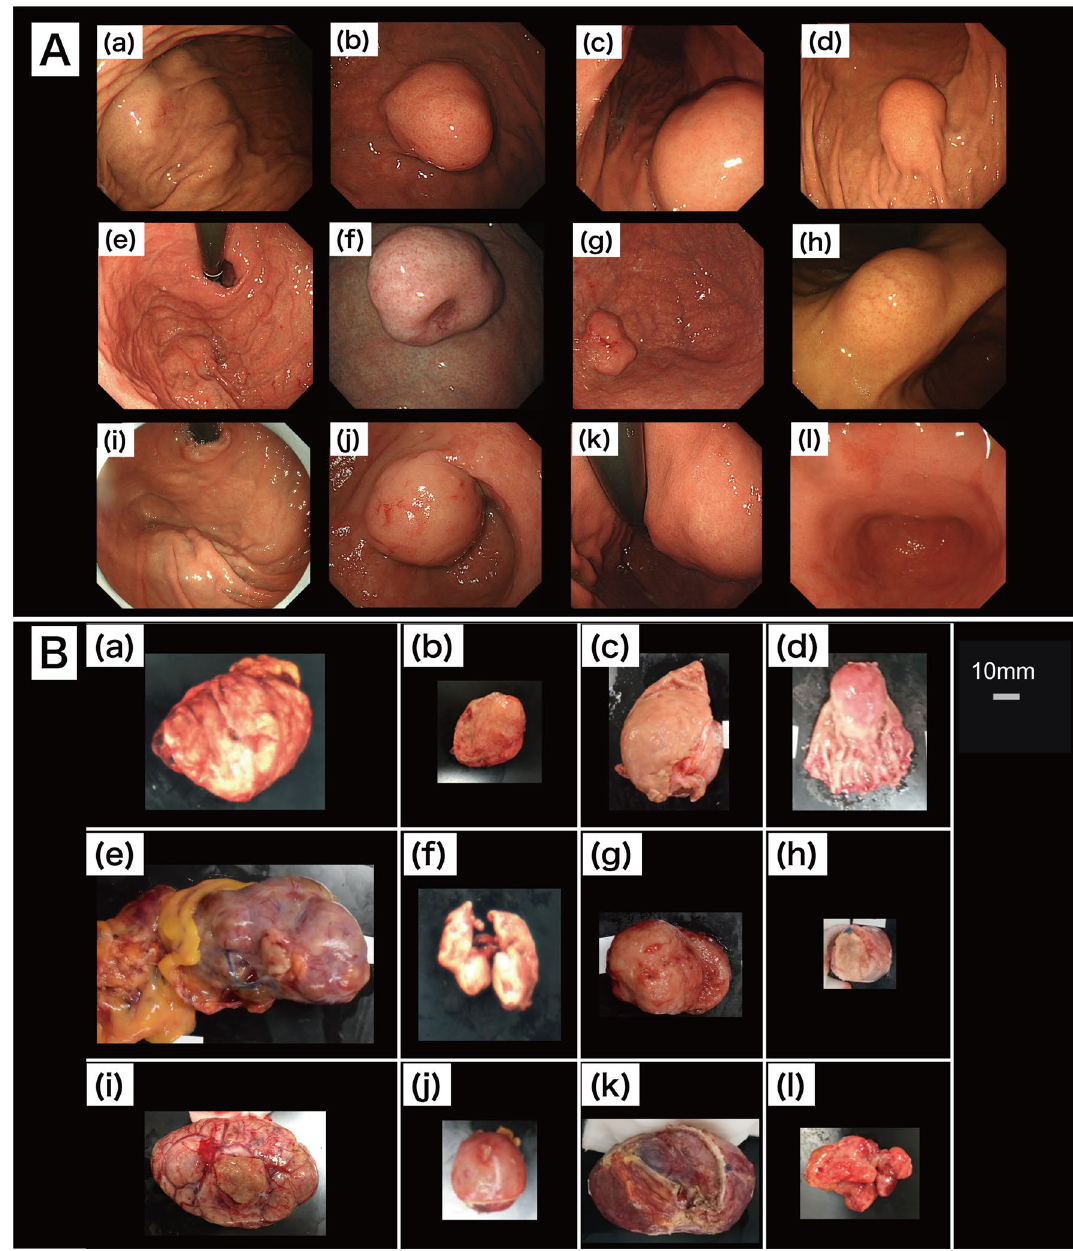
Figure 1. Endoscopic view and photographs of excised specimens of GIST. ( A ) (a–k) GIST can be seen as SMT protruding into the gastric lumen. ( A ) (l) SMT cannot be seen with an endoscope. ( B ) (a–l) Visible light photographs of specimens captured by a digital camera. GIST gastrointestinal tumor, SMT submucosal